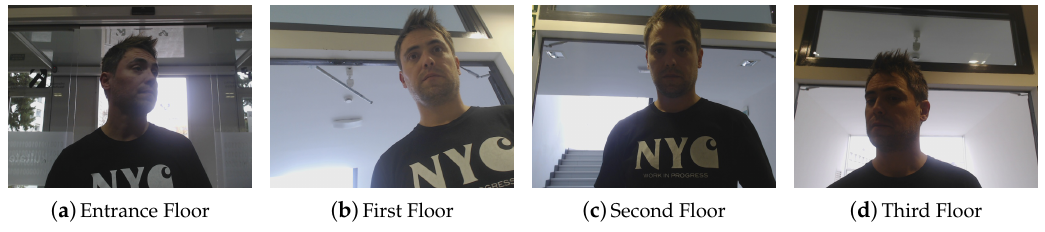
Figure 4. Perspectives from the different robots.